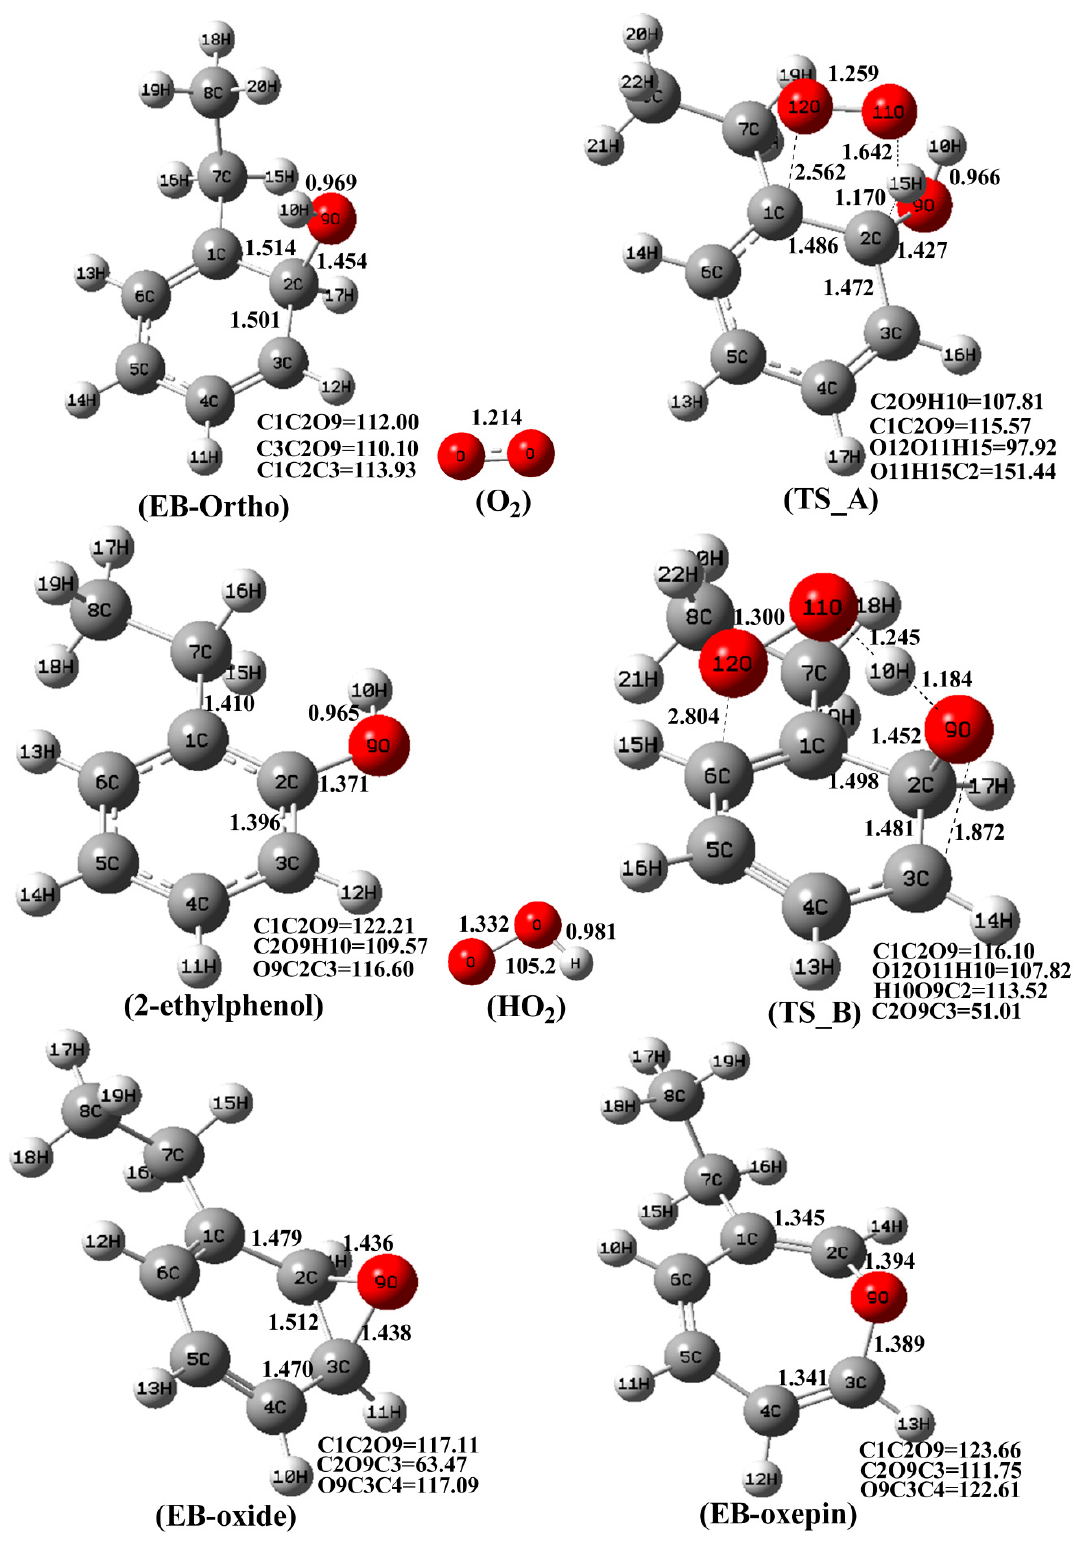
Figure 3. Optimized geometries of various species of Path A and Path B, as shown in Figure 1, at the BHandHLYP/6-311++G(d,p) level (Bond length: Å, Bond angle: °).